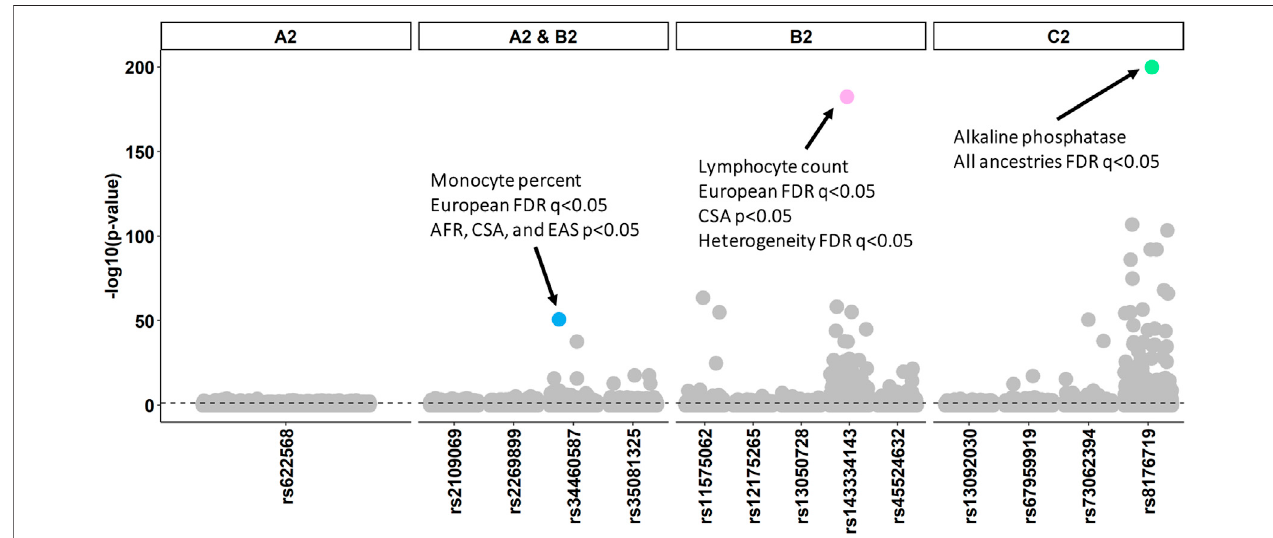
FIGURE 3 | Phenome-wide association study (PheWAS) of risk loci from three COVID-19 outcomes: A2: very severe respiratory con fi rmed COVID-19 versus population, B2: hospitalized COVID-19 versus population, and C2: COVID-19 versus population. Each facet details the pleiotropic effects of loci detected by GWAS of the indicated COVID-19 outcome. Each data point corresponds to a single trait assessed in UK Biobank participants of European descent. For the top associations of interest,theassociationbetweenSNPandphenotypesacrossallancestriesisdescribed.DetailsoftheeffectofeachSNPinsixpopulationsfromthePan-ancestry UKB are provided in Supplementary Table S5